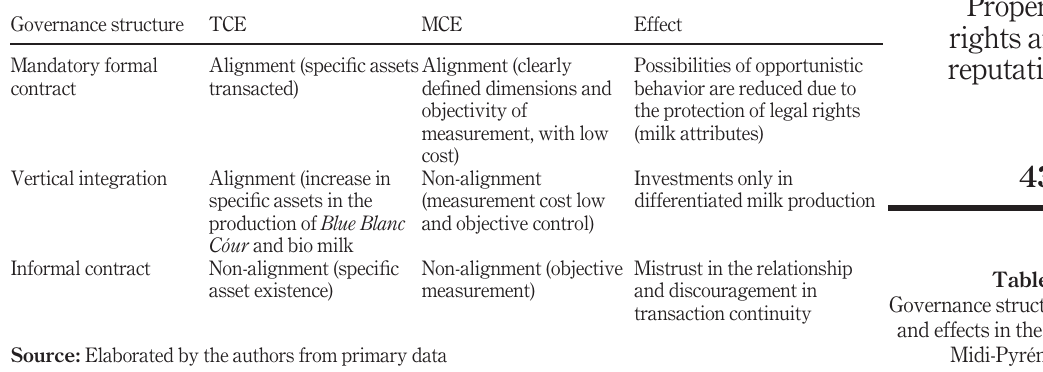
Table 6. Governance